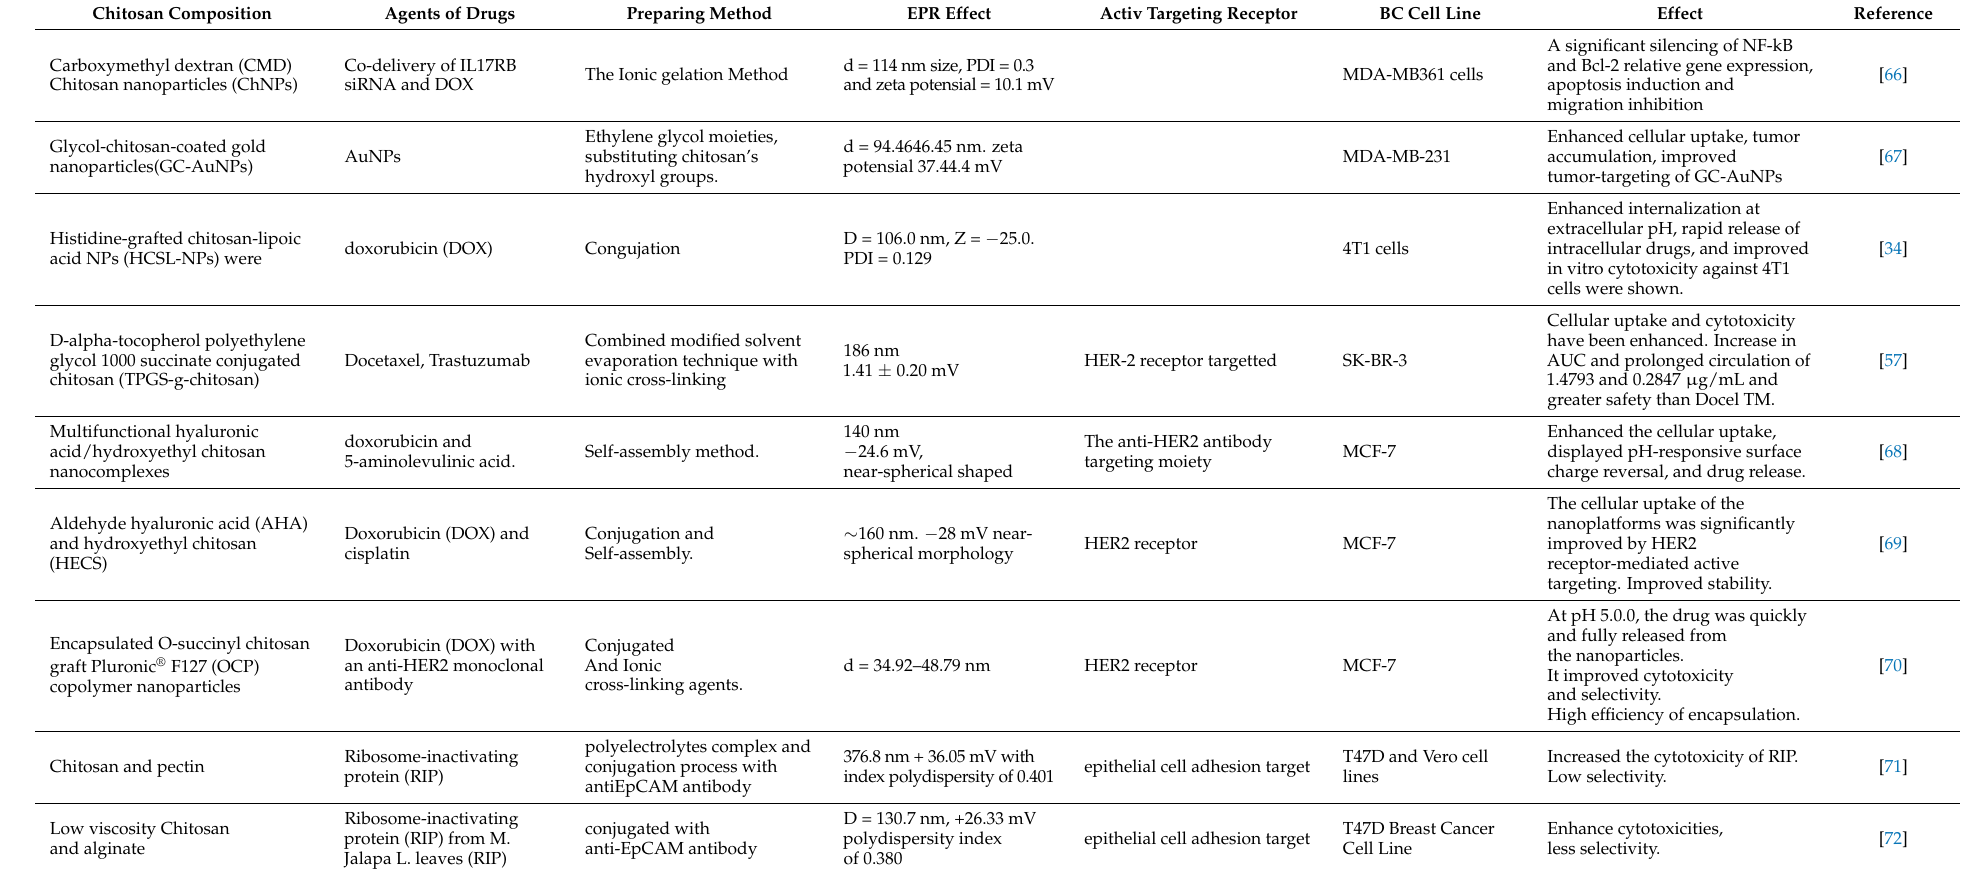
Table 2. Studies on Chitosan-based Nanoparticles of Targeted Drug Delivery